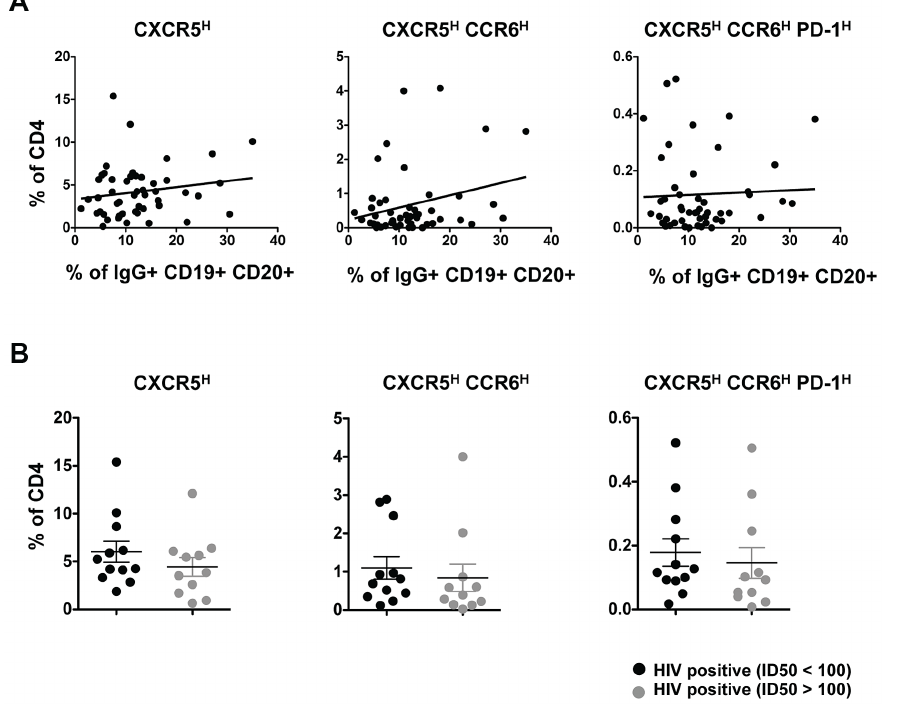
Figure 5. Relationship between pT FH cells and neutralization activity. ( A ) Correlative analysis showing the frequency (%) of CXCR5 high , CXCR5 high CCR6 high and CXCR5 high CCR6 high PD-1 high populations in total CD4 cells from HIV-infected (treatment naı¨ve) subjects (n=50) versus the frequency of IgG + B cells in the total B population. Correlations were analyzed using the nonparametric Spearman test. ( B ) Pooled data showing the frequency (%) of CXCR5 high , CXCR5 high CCR6 high and CXCR5 high CCR6 high PD-1 high populations in total CD4 cells based on neutralization activity (median ID50 . 100 or , 100). No significant differences were determined.